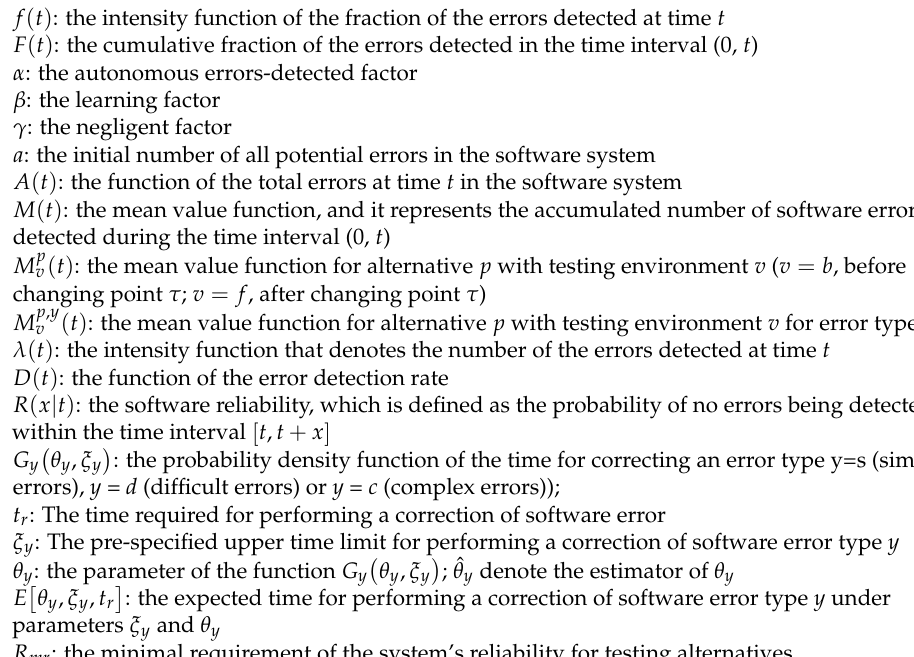
Table 1. The Notations and